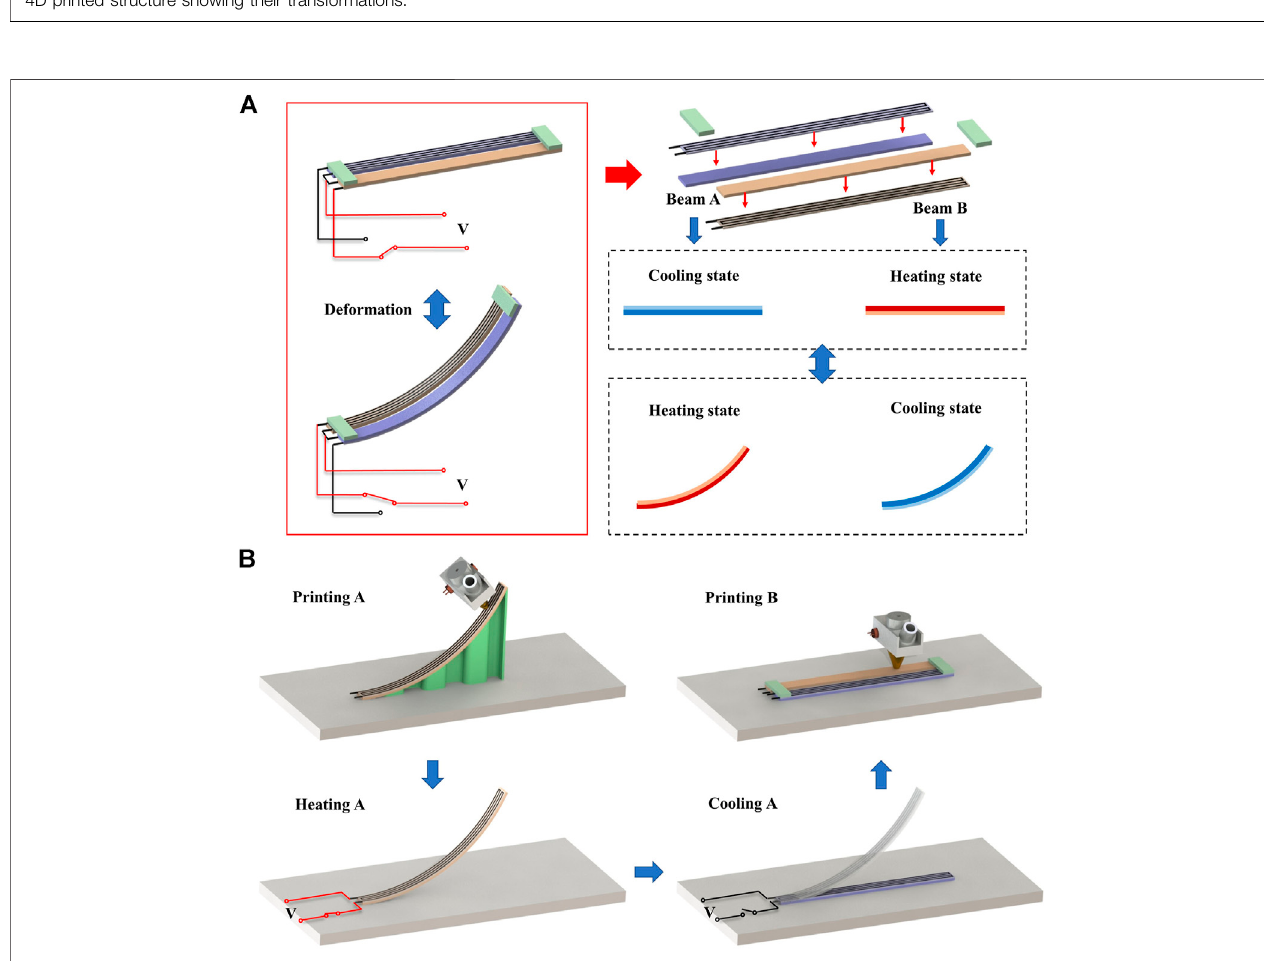
FIGURE 2 | Design of alternate-actuated structure for (A) two groups of beam structures and (B) printing process.